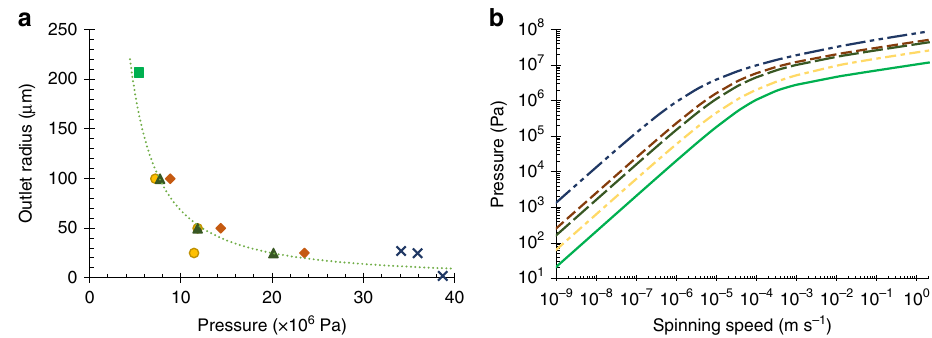
Fig. 5 The effect of geometric variation on pressure requirements. a The relationship between required pressure at inlet, and duct geometry (linear ( yellow circles ), parabolic ( orange diamonds ), exponential ( dark green triangles ), zero taper ( pale green square ), and literature ( blue x ) values) at natural spinning speeds (0.02 m s − 1 ). Greater and more severe tapers both increase pressure required to fl ow representative feedstock. b The effect of geometric variation on required inlet pressure. A limited, representative dataset is shown for clarity (x8 diameter reduction of parabolic ( orange dots ), exponential ( dark green dashes ), and linear tapers ( yellow dot-dashes )), all curves lie between the limits shown above of Kojic ’ s model ( blue dot-dashes ), and the limiting case (zero taper, pale green ). See Supplementary Fig. 3 for further